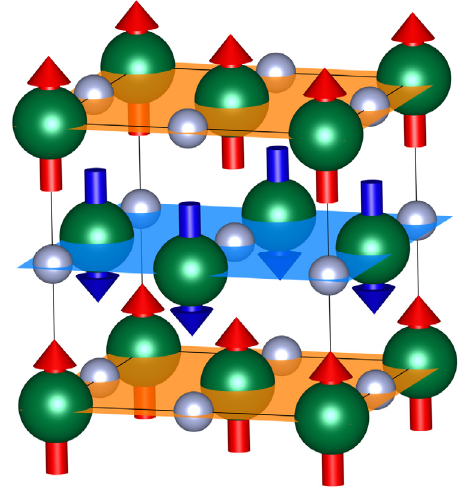
Figure 2. Schematic crystal structure of MnN: green (bigger) spheres correspond to manganese atoms, while smaller, lighter spheres represent nitrogen atoms. The AF-I antiferromagnetic ground state with spin alignment along the c-axis is represented by the arrows (planes) of red and blue (orange and light blue) color.